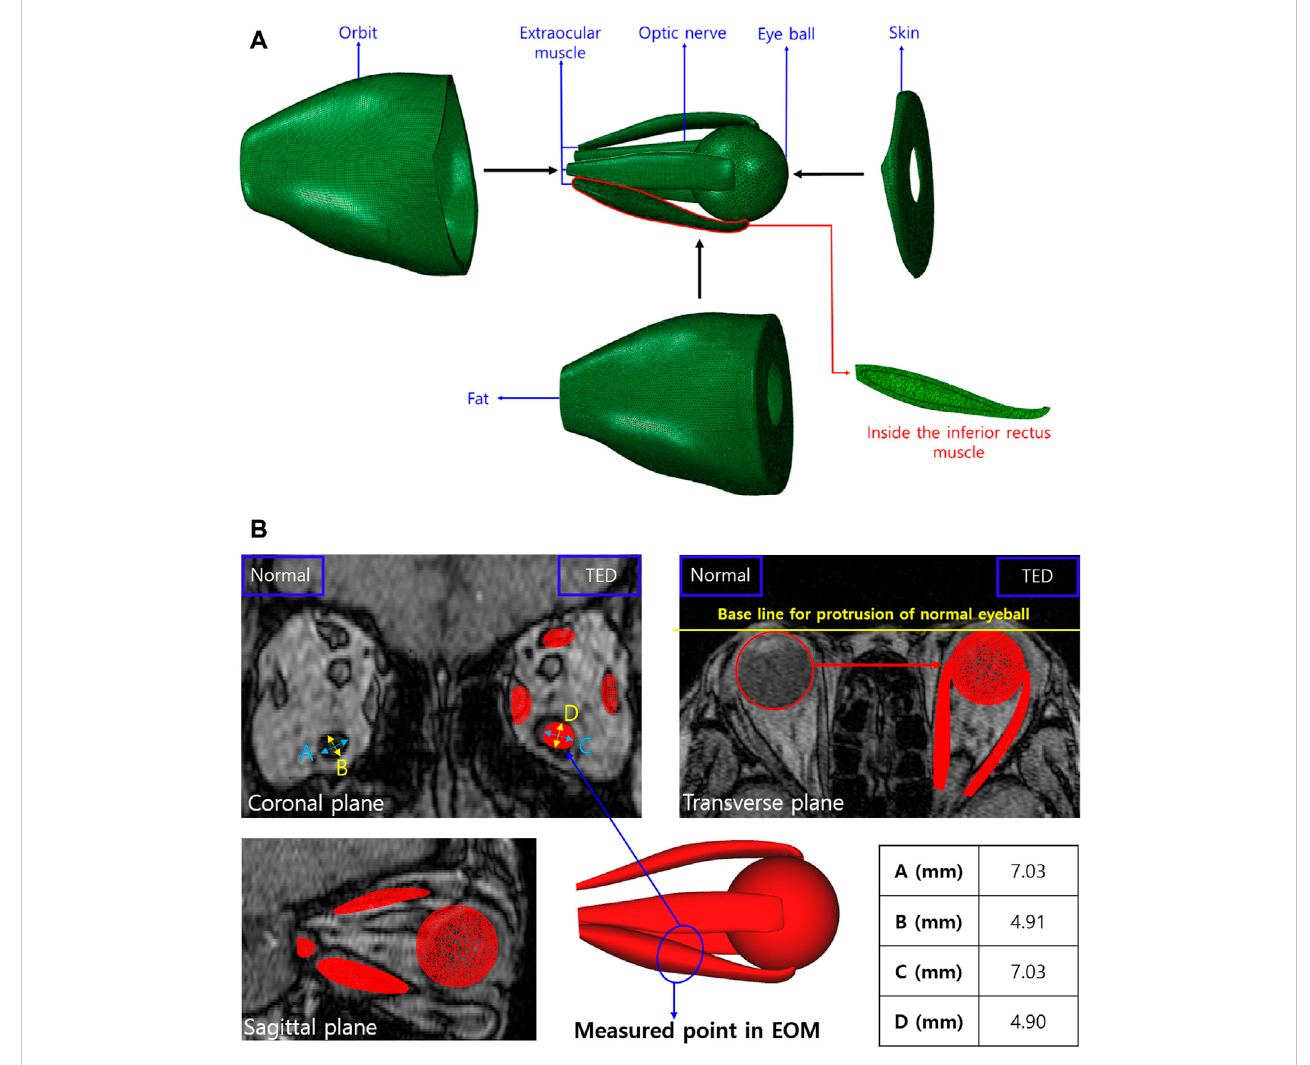
FIGURE 2 (A) Finite element model of orbit and intraorbital tissue. (B) Validation between the medical image and fi nite element model.